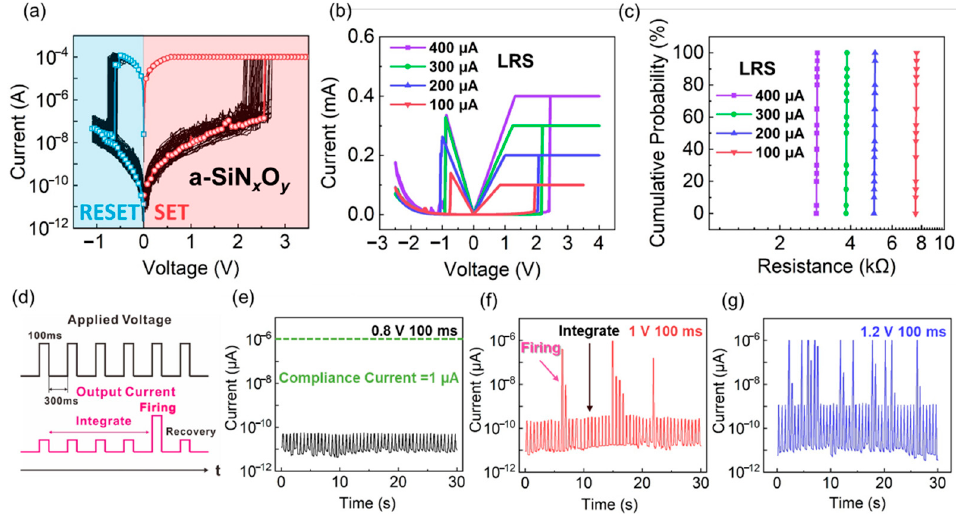
Figure 5. ( a ) Memory switching characteristic of Al/a-SiN x O y :H/P + –Si device with I cc of 100 µA; ( b ) Multilevel resistive switching characteristic of Al/a-SiN x O y :H/P + –Si device under different I cc from 100 to 400 uA; ( c ) The cumulative probability of multilevel states under different I cc for 20 switching cycles; ( d ) The method and mechanism of the integrate-and-fire function of neuron tests; ( e – g ) The output results when the amplitude is 0.8 V, 1 V and 1.2 V, respectively. There is no firing when the amplitude of the applied pulse is 0.8 V. The firing occurs when the amplitude is 1 V. And the firing frequency increases when the amplitude of the applied pulse increases to 1.2 V.